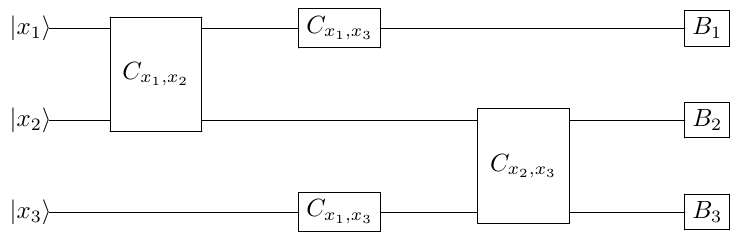
Figure 3. The unitary circuit required to solve MaxCut using QAOA. Note that no two qubit unitary operators can be implemented simultaneously since any two act on one common qubit. Here, C x a two qubit unitary, but is drawn as two single qubit unitary operators to avoid overlapping with